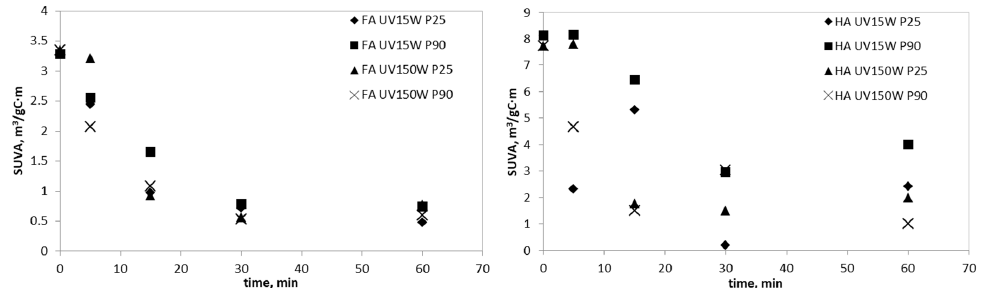
Figure 4. The change of SUVA parameter during the photocatalysis process.